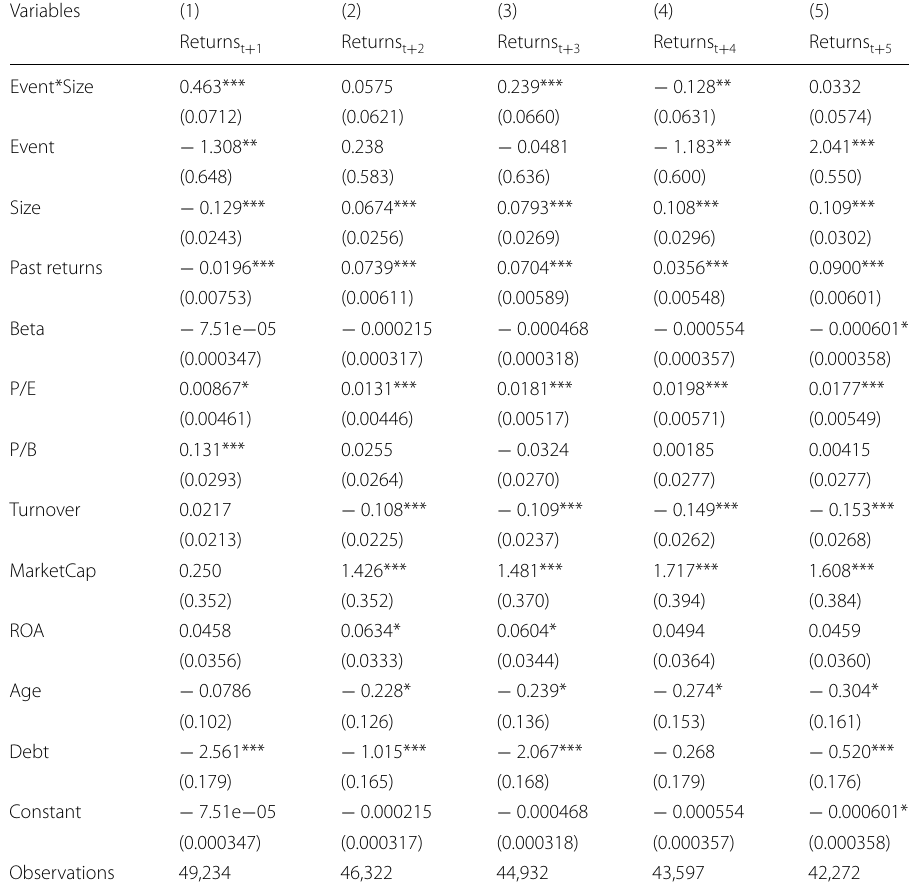
Table 5 Light a lamp, size and